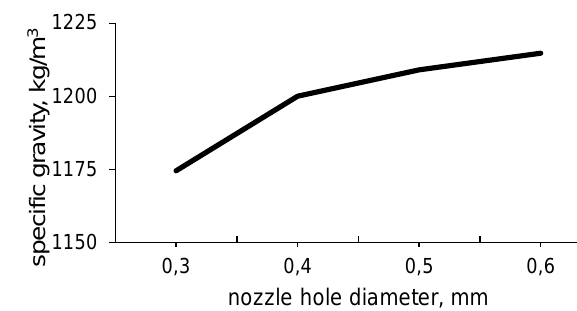
Figure 3: The relation of nozzle diameter and product